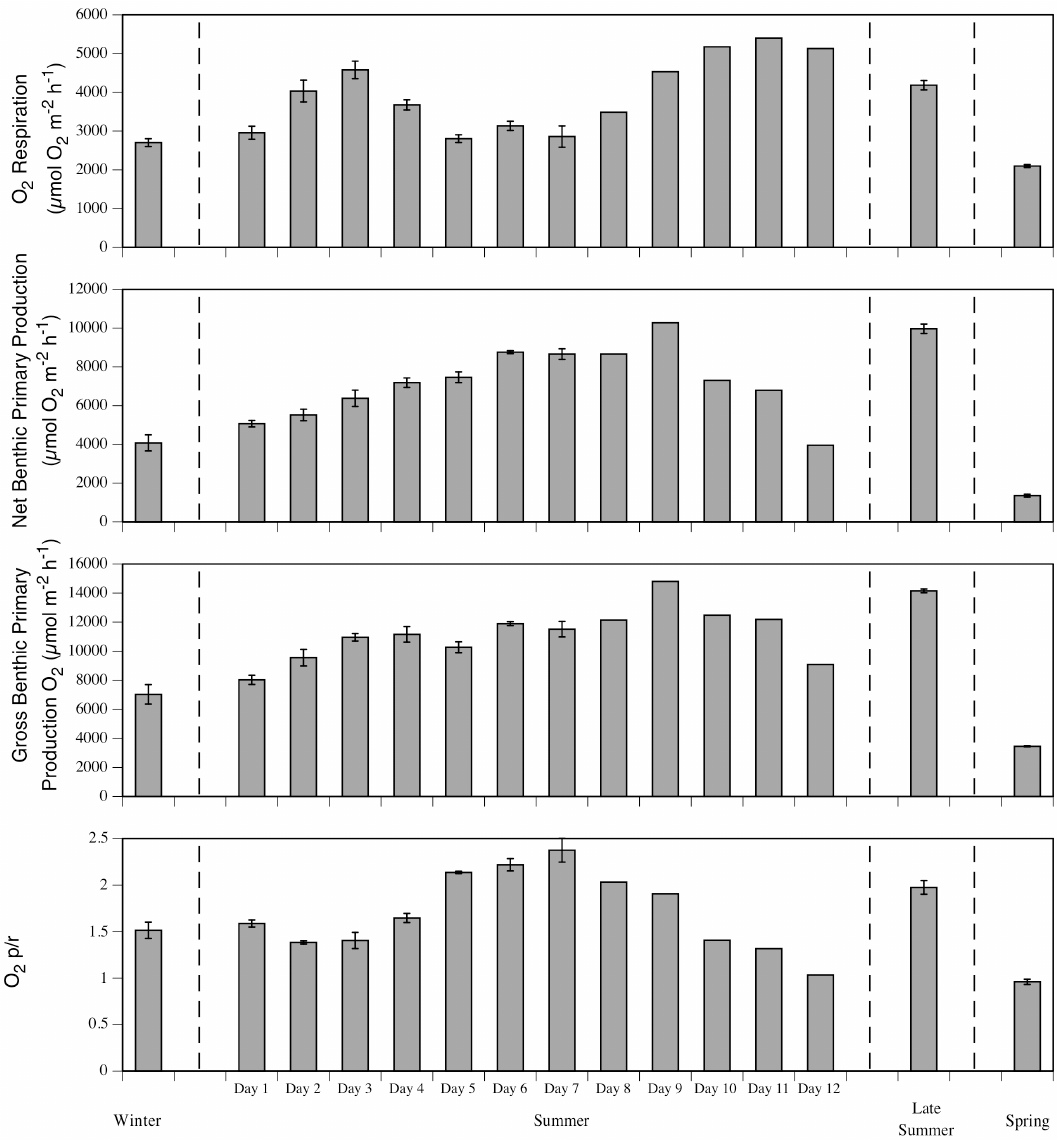
Fig. 1. Benthic dark O 2 consumption (respiration), light O 2 fluxes (net primary production (NPP), gross primary production (GPP) and GPP/respiration ( p/r ) (mean ± SE where replicated; see Table